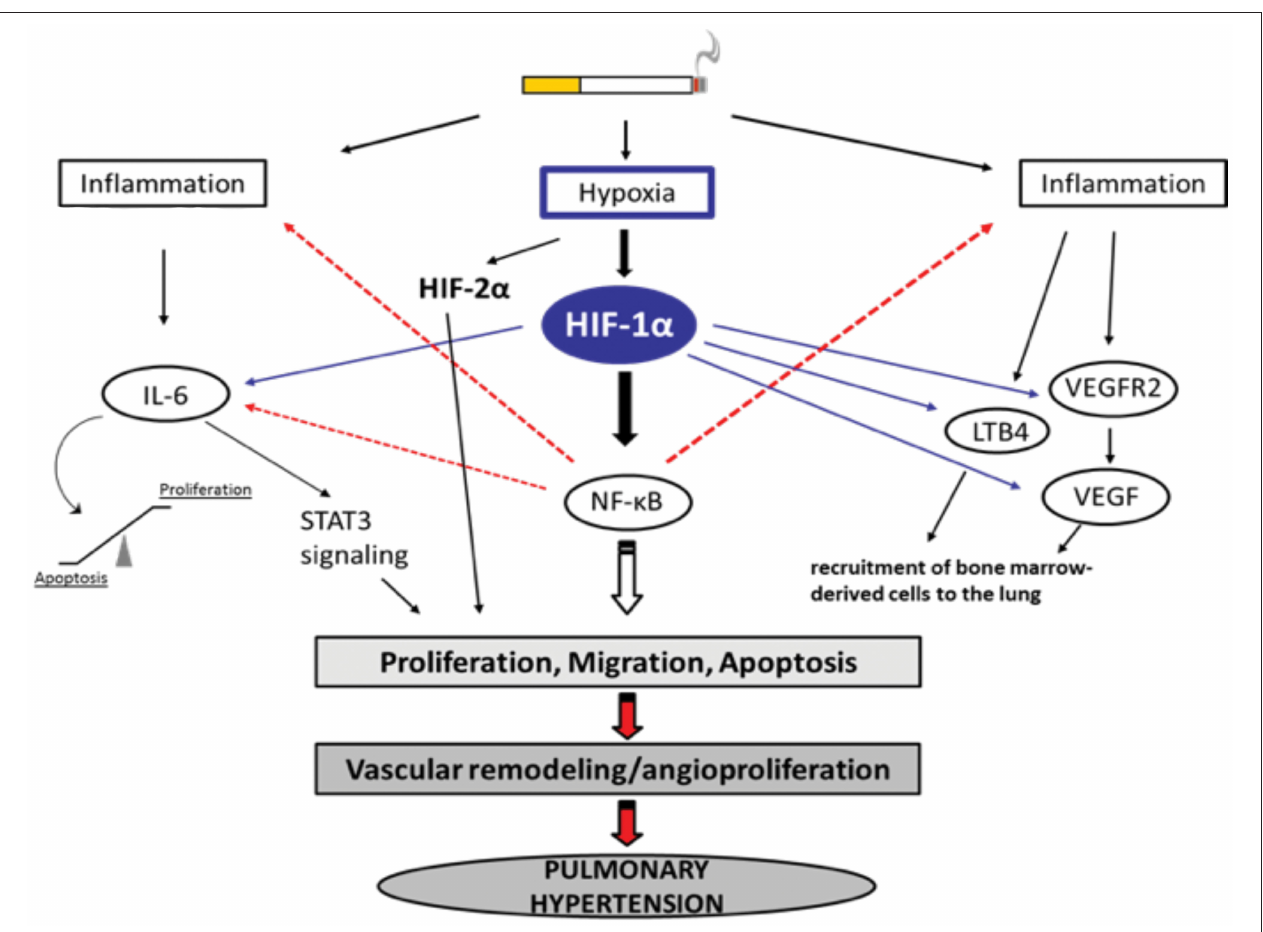
FIGURE 1 | Selection of possible hypoxia-dependent mechanisms contributing to pulmonary vascular remodeling in COPD-PH. Cigarette smoke-induced airway obstruction and emphysema can result in hypoxia. Hypoxia, amongst others, activates HIF-1 α which can trigger pathways associated with inflammation, the recruitment of bone marrow-derived cells, and alterations in proliferation/apoptosis balance of vascular endothelial and smooth muscle cells (SMC). Increased proliferation of SMCs causes narrowing of the vessels resulting in pulmonary hypertension. All important acronyms of the molecules are explained in the